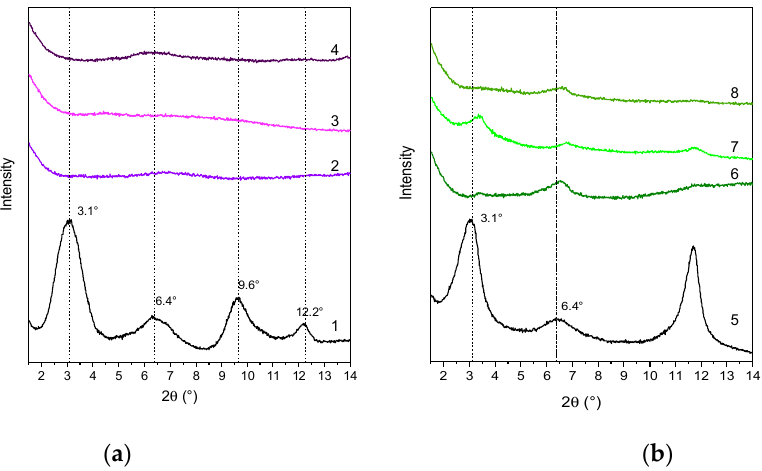
Figure 5. XRD patterns of LDH-GA (1), PLA/LDH-GA (2), PBS/LDH-GA (3), and PLA/PBS/LDH- GA (4) ( a ) and LDH-DS/GA (5), PLA/LDH-DS/GA (6), PBS/LDH-DS/GA (7), and PLA/PBS/LDH- DS/GA (8) ( b ).